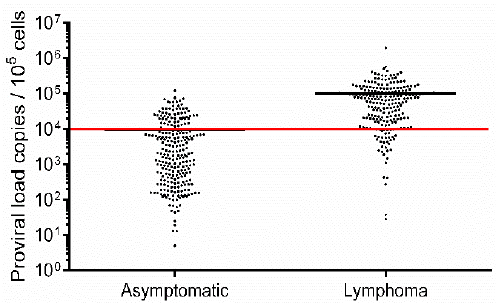
Figure 1. Proviral load (PVL) estimation in Bovine leukemia virus (BLV)-infected but clinically and hematologically normal cows (asymptomatic cows) and BLV-infected cows with lymphoma (lymphoma cows). Blood samples were obtained from 250 asymptomatic (Table S1) and 221 lymphoma (Table S2) cows in a nationwide survey in Japan. BLV infection was analyzed using BLV-CoCoMo-qPCR-2. The red line represents a BLV PVL of 10,000 copies / 10 5 cell, which was set as the threshold between high- and low-PVL cows. Table 1. Summary of PVL distribution in asymptomatic cows and lymphoma cows. Status